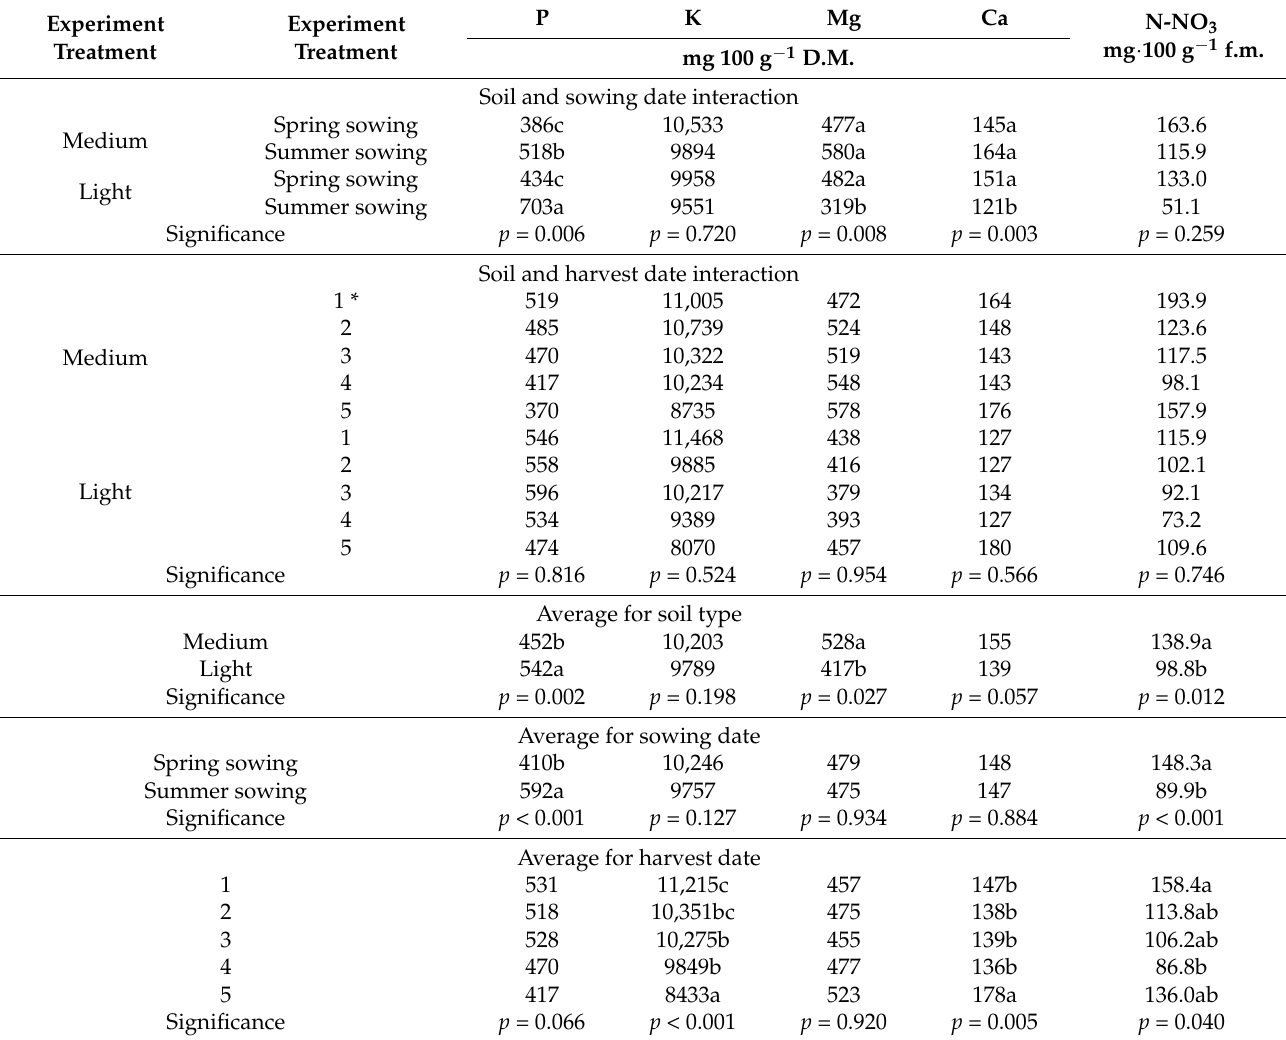
Table 6. The effect of soil type, sowing date and harvest date on quinoa minerals composition and N-NO 3 content. Average from years